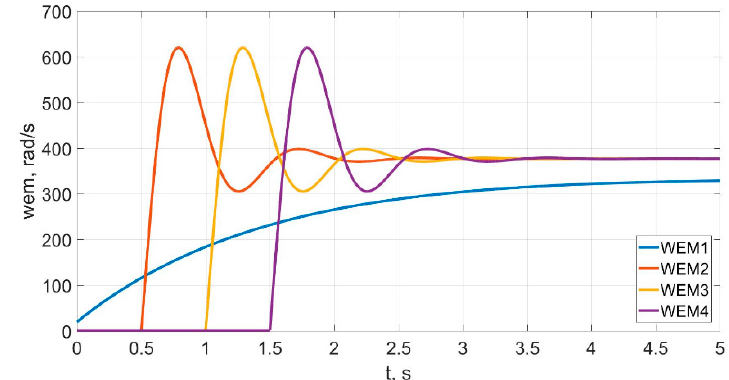
Figure 8. Angular velocity of electric motors: EM1, EM2, EM3, EM4.